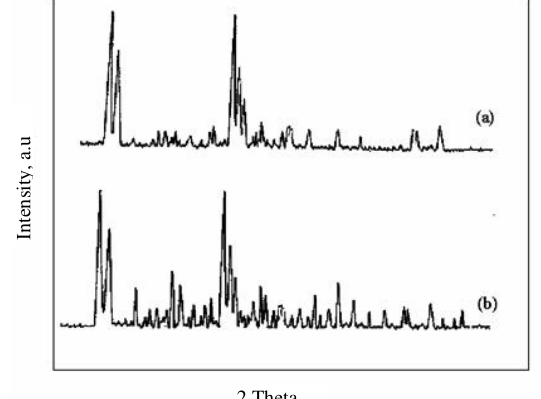
Figure 2. X-ray powder diffraction patterns of (a) Na-ZSM-5 (b) PNa